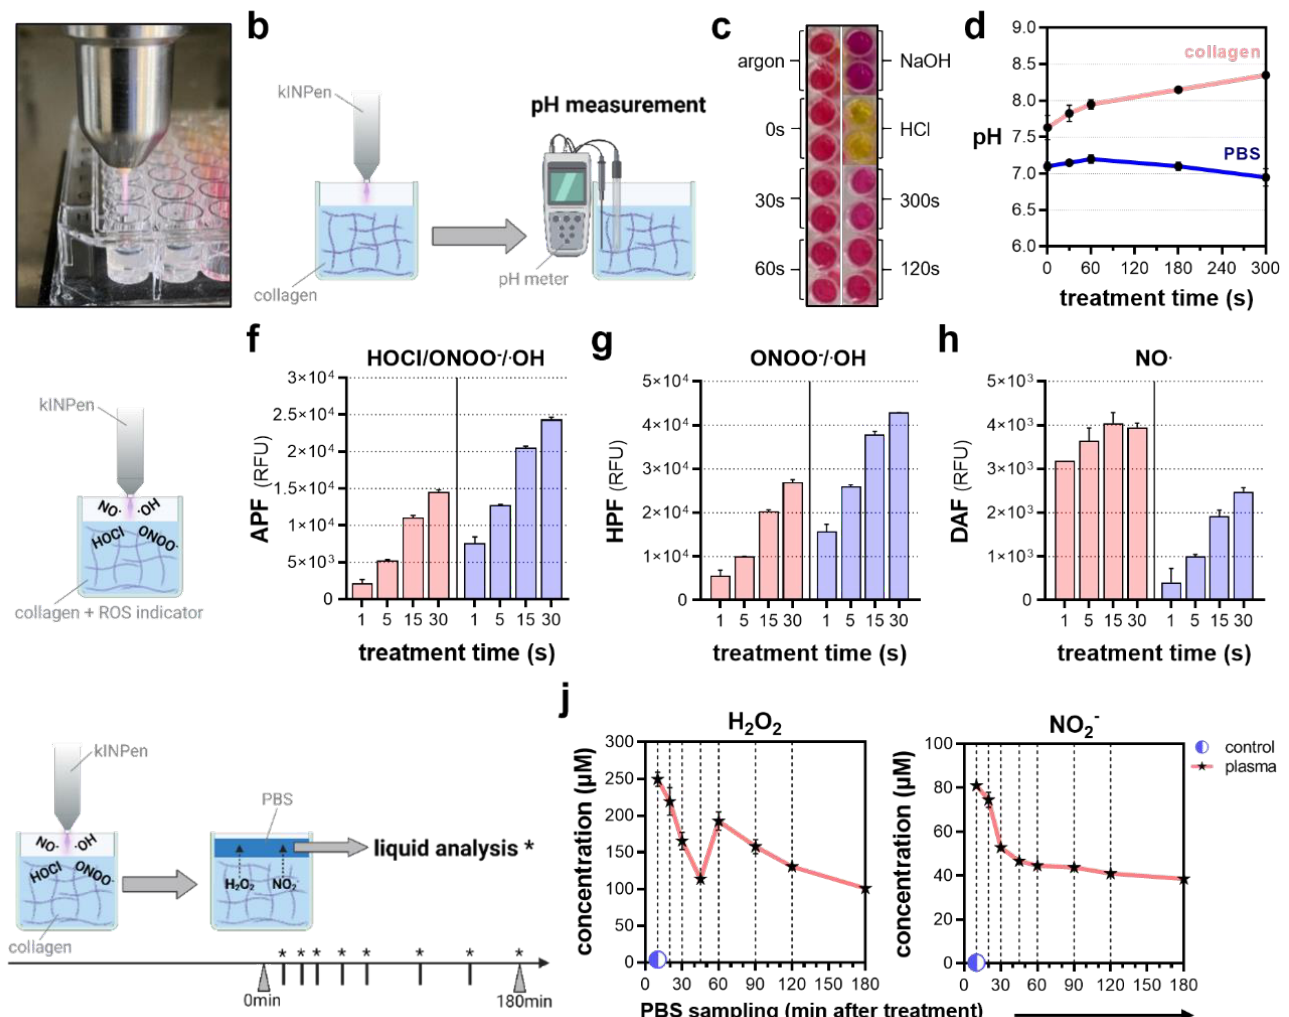
Figure 4. Profiling of reactive oxygen and nitrogen fingerprints after plasma treatment. ( a ) Representative image of collagen plasma treatment; ( b ) schematic overview of pH measurement after plasma treatment using a pH meter; ( c ) representative images of phenol red-colored collagen after plasma treatment and acidic and basic controls; ( d ) pH in collagen and PBS after plasma treatment; ( e ) schematic overview of the detection of short-lived ROS/RNS using fluorescent, redox-sensitive probes; ( f ) relative fluorescence intensity of aminophenyl fluoresceine (APF) indicative of hypochlorous acid (HOCl), peroxynitrite (ONOO − ) and hydroxyl radicals (OH . ); ( g ) relative fluorescence intensity of hydroxyphenyl fluoresceine (HPF) indicative of ONOO − and OH . ; ( h ) relative fluorescence intensity of diaminofluoresceine (DAF) indicative of nitric oxide (NO . ); ( i ) schematic overview of PBS sampling to quantify the deposition and release of ( j ) hydrogen peroxide (H 2 O 2 ) and nitrite (NO 2 − ) after plasma treatment in collagen. The graphs show the mean ± standard error of the mean (SEM). * = liquid analysis was performed at this timepoint.